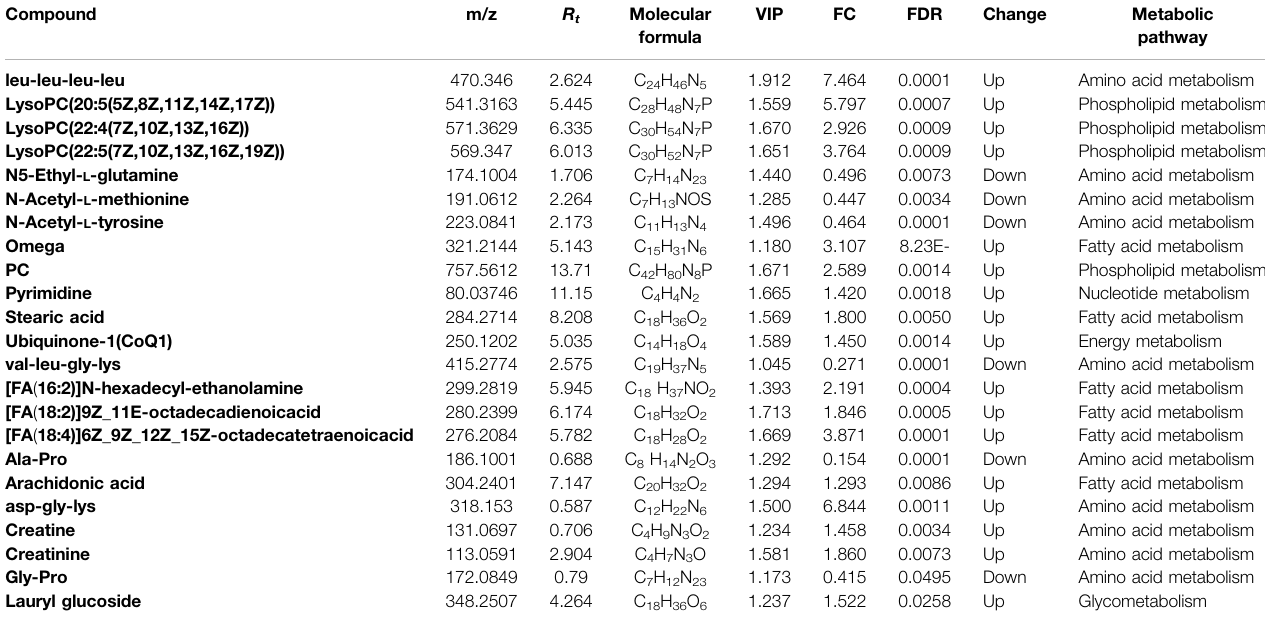
TABLE 4 | The representative differential metabolites identi fi ed in serum samples between SST treatment and base-line treatment. Compound m/z R t Molecular